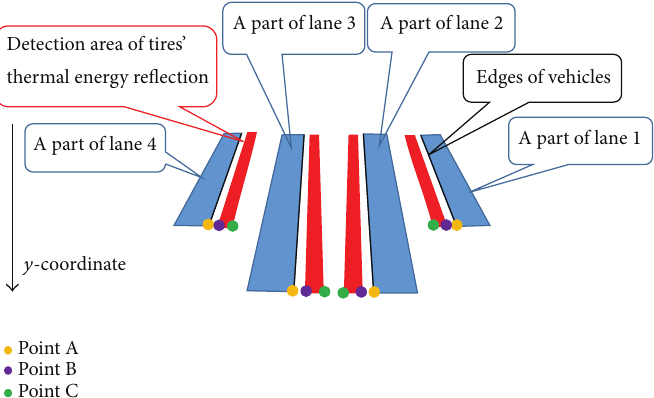
Figure 11: Positions of edges of vehicles and detection areas.